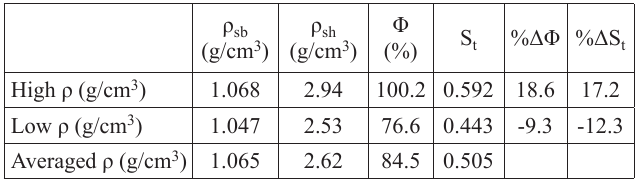
Fig. 6. Hydrostatic models of Baculites compressus with computed per- centage of the phragmocone emptied for neutral buoyancy ( Φ ) and hy- drostatic stability (S t ). All models are oriented dorsum-left. The centers of buoyancy are marked by the tip of the higher pyramid. The total centers of mass are marked by the tip of the lower pyramid. Each material of unique density is designated a color (green, soft body; red, cameral gas; blue, cam- eral liquid; transparent grey, shell). A . Virtual model with 40% body cham- ber length to total length (BCL/L). B . Virtual model with 33% BCL/L and adorally distributed cameral liquid. C . Virtual model with 33% BCL/L and adapically distributed cameral liquid. D , E . B. compressus model modified with a concave dorsum similar to B. grandis and 33% BCL/L. Adorally ( D ) and adapically ( E ) distributed cameral Table 2. Different density values applied to the Baculites compressus hydrostatic model with an even distribution of cameral liquid and gas. High and lower density ( ρ ) values applied to the soft body (sb) and shell (sh) resulting in different percentages of the phragmocone to be emptied ( Φ ) and different stability indices (S t ). Percent change in hydrostatic parameters is denoted by % Δ .